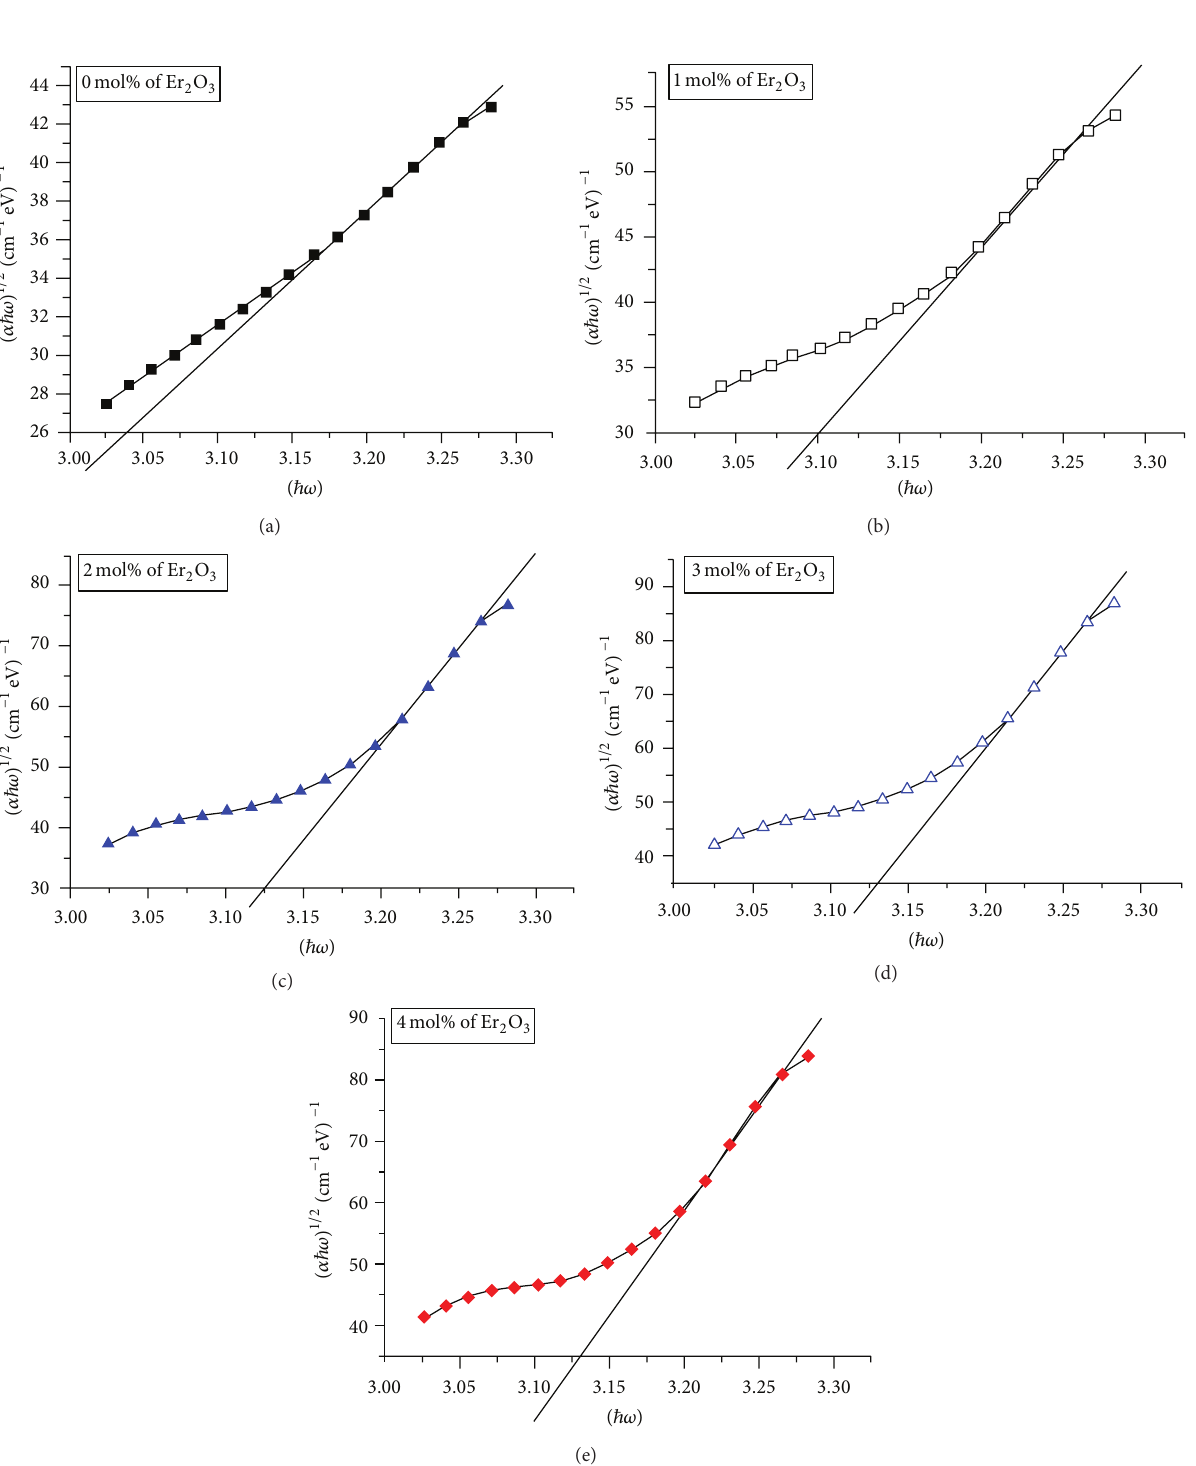
Figure 4: Graph of quantity (𝛼ℏ𝜔) 1/2 against photon energy (ℏ𝜔) for ( 80 − 𝑥 )TeO 2 -20ZnO- 𝑥 Er 2 O 3